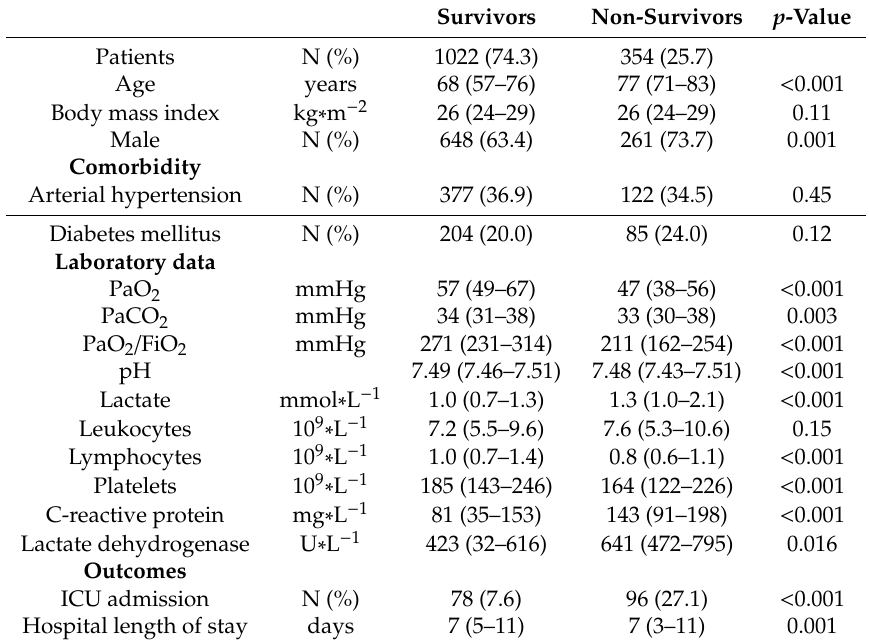
Table 2. Characteristics of survivors and non-survivors at hospital